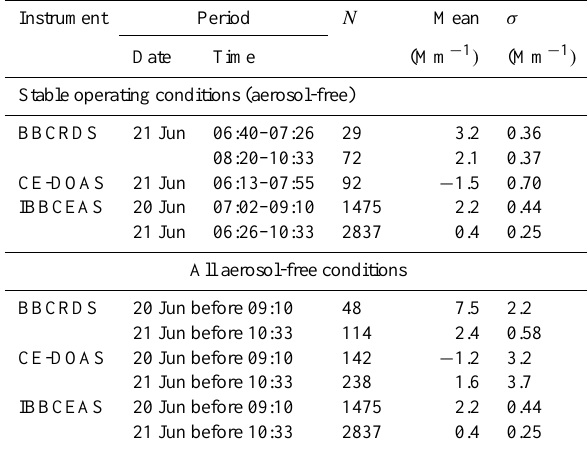
ing the linear regressions of each correlation. For the data acquired on 20 June, the slopes of the correlation plots are similar for the BBCRDS (0.90) and CE-DOAS (0.88) sys- tems, with respective correlation coefficients, R 2 , of 0.983 and 0.978. Excellent agreement was found between the mea- of 0.998 (BBCRDS) and 0.991 (CE-DOAS). The slopes